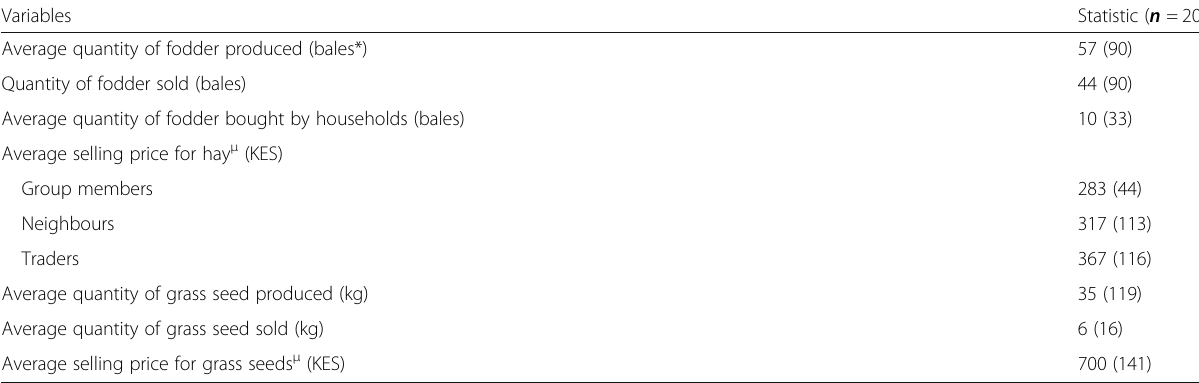
Table 3 Fodder production and sale by producer